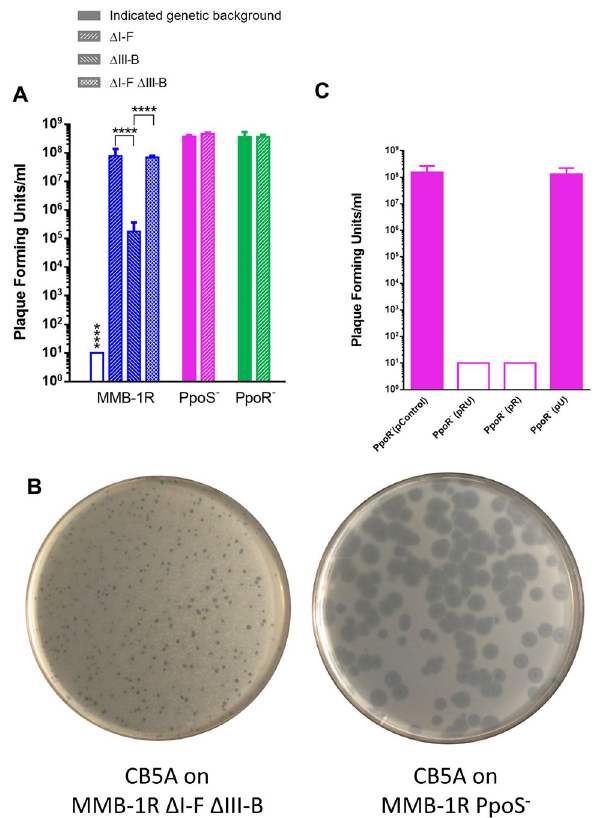
Figure 4. Susceptibility of different M. mediterranea strains to phage CB5A. ( A and C ) Plaque forming units in double layer assays in MNG medium. Empty columns indicate the detection limit when no phage plaques were detected in the assays at the higher phage concentration. ( A ) Only the data of wild type strain (MMB-1R) and the ΔIII-B strains showed statistical difference among themselves and with all the other samples. Error bars represent means ± s.d (n = 3) **** P < 0.0001 according to one-way ANOVA followed by Tukey’s post-test. ( C ) No statistical difference was observed between PpoR - control and PpoR - (pU, containing the uvrC gene). No plaques were observed in lawns of PpoR - (pR, containing ppoR ) or PpoR - (pRU, containing ppoR-uvrC ) ( B ) CB5A plaques on lawns of the ΔI–F ΔIII-B strain (left) and PpoS −